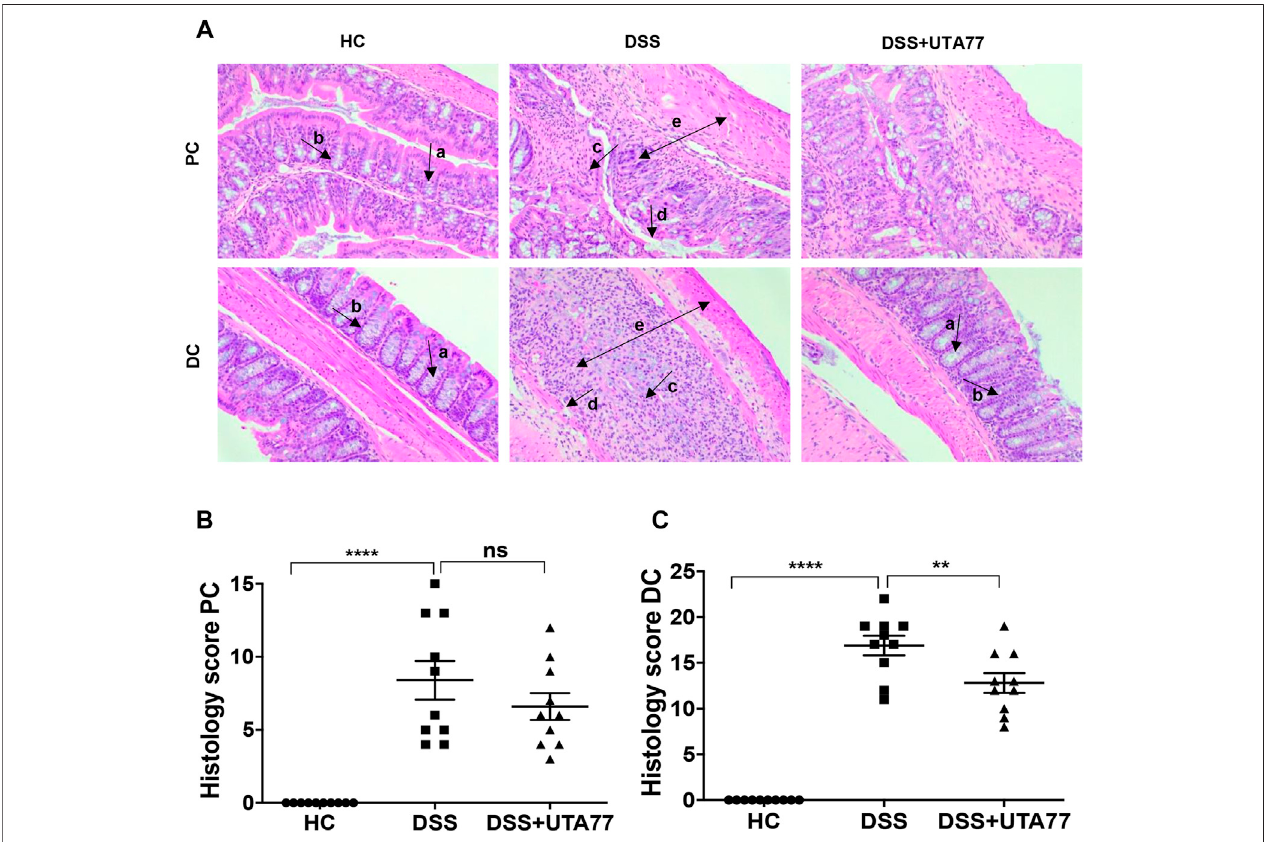
FIGURE 3 | Effect of UTA77 on histopathology in DSS-induced colitis. (A) Histological representation of proximal colon (PC) and distal colon (DC) sections stained withH&Eforhealthymice (HC), DSS-controlmice(DSS),and DSS+UTA77-treated mice(DSS +UTA77) at × 20magni fi cation. (B) and (C) representthehistopathology scores for each animal calculated after microscopic analysis of tissue sections from the PC and DC. Statistical signi fi cance among groups was evaluated by one-way ANOVA followed by Tukey ’ s posttest. **p < 0.01, ****p < 0.0001, and ns: nonsigni fi cant. Data expressed as mean ± SEM ( n (cid:1) 10/group). Arrows indicate goblet cells (a), crypts/regeneration of crypts (b), in fl ammatory cells in fi ltration (c), epithelium surface erosion (d), and submucosal oedema (e).